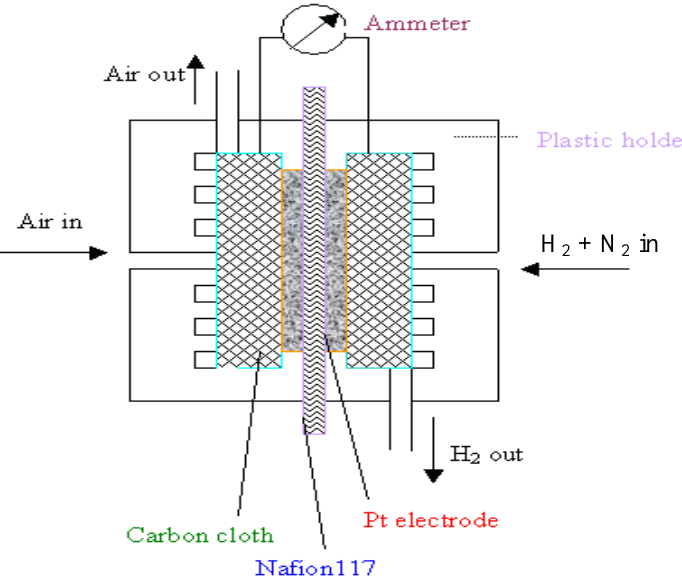
Figure 1. Schematic diagram of the ionic polymer-metal component sandwiched between Plexiglas